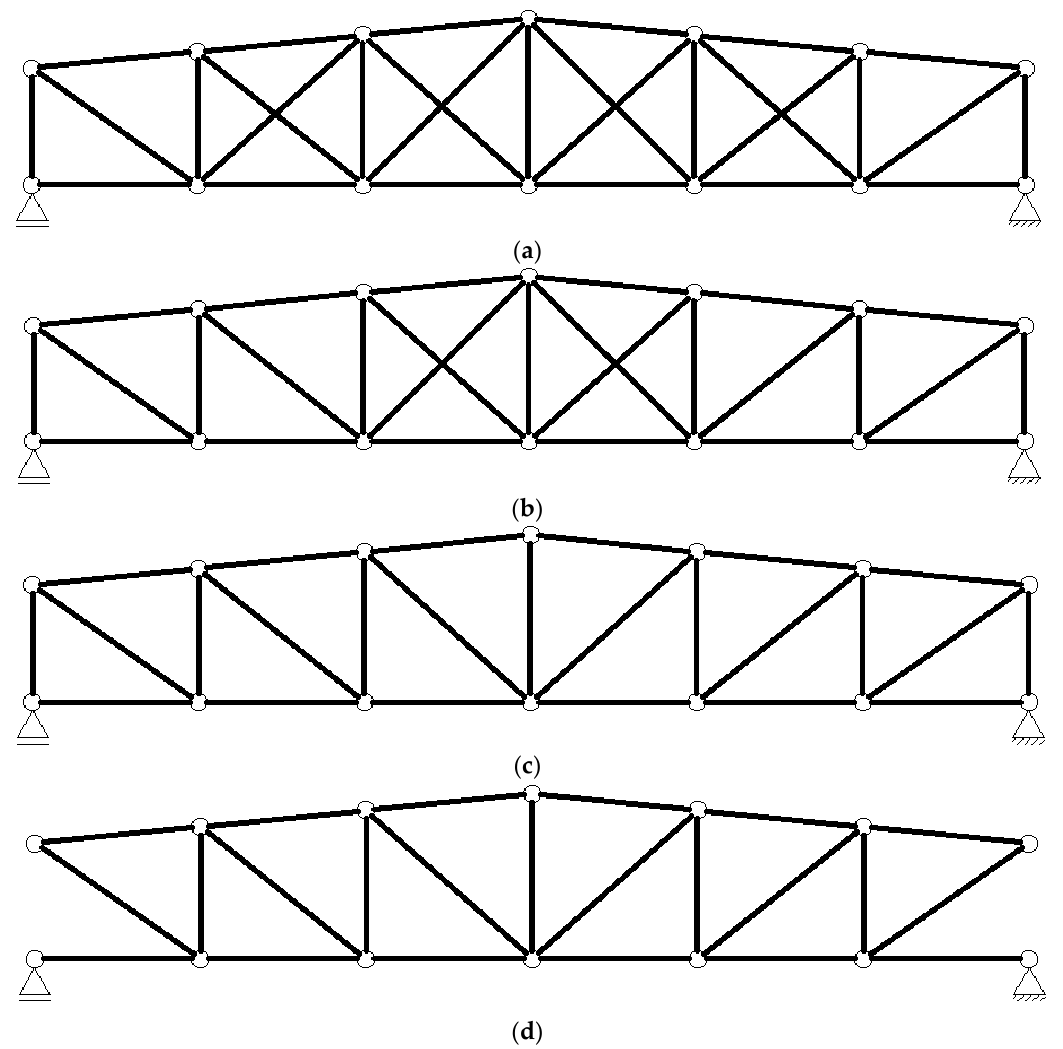
Figure 3. Change in the static scheme of truss “0” along with the fire duration: ( a ) t fi = 10.83 min (650 s); ( b ) t fi = 20 min (1200 s); ( c ) t fi = 37.35 min (2241 s); and ( d ) t fi = 59.75 min (3585 s).